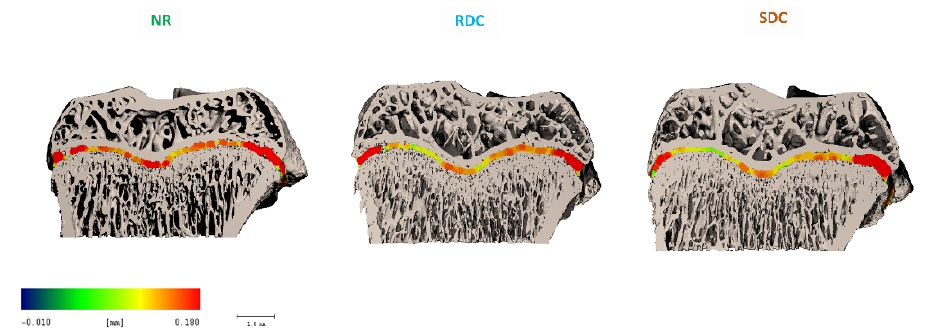
Figure 4. Representative micro-CT images of the proximal tibia GP after the refeeding period. Colors represent epiphyseal GP height in mm. NR group, not restricted group; RDC group, refeeding with rapid digestible carbohydrates diet; SDC group, refeeding with slow digestible carbohydrates diet.